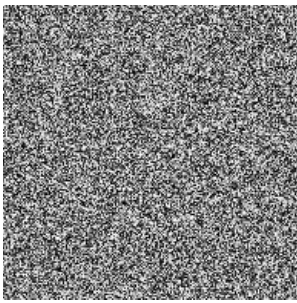
Figure 5. Bit-wise XOR of two